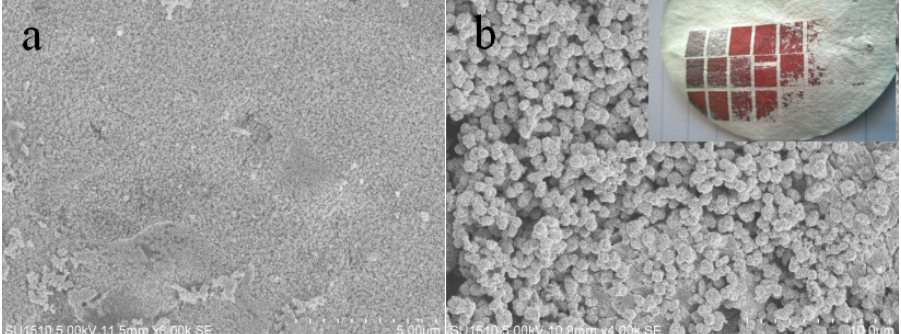
Figure 4. Size distribution of silver particles on the FP/PAN film after laser irradiation.